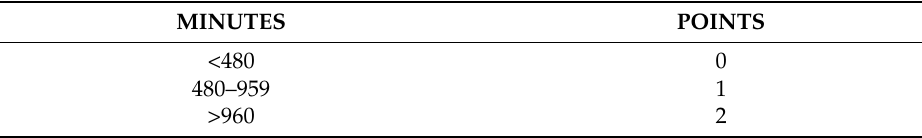
Table A4. Duration of Table A5. Duration of surgery.